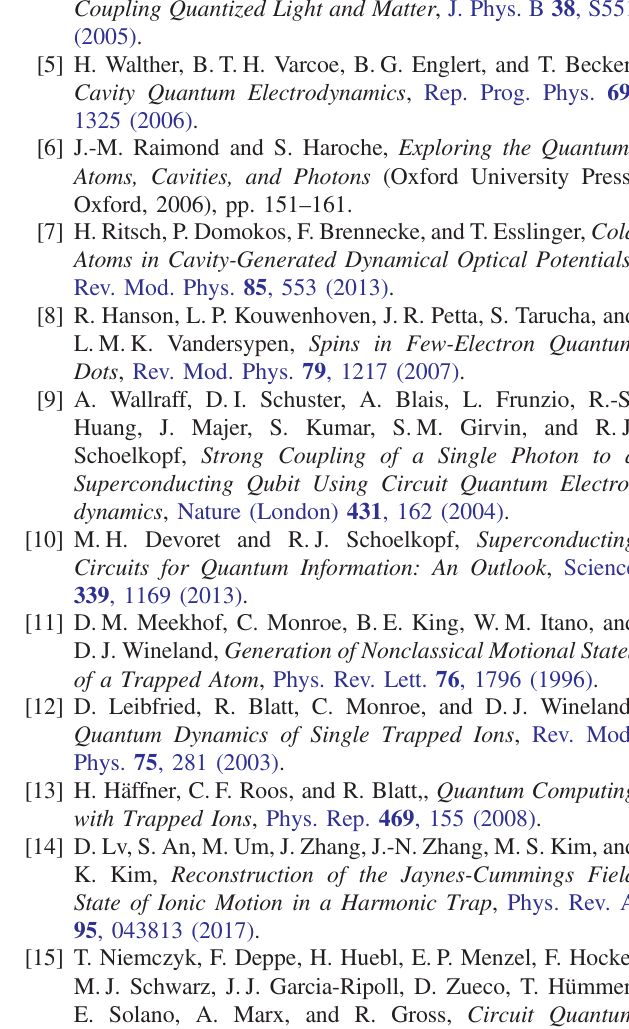
FIG. 5. Spin and phonon dynamics under the QRM for different coupling regimes with the imbalance between Ω and the purple curves correspond to the results of numerical simulations with Ω ϵ ¼ 3% , for the cases shown Fig.